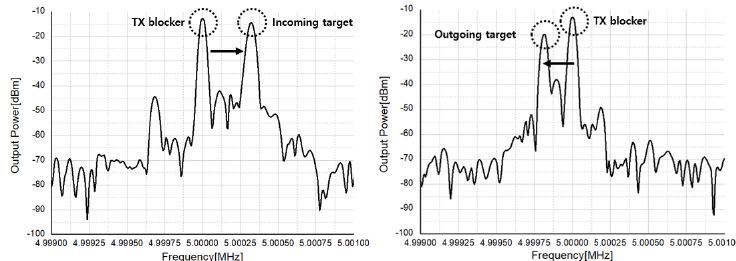
Figure 45. Measurement result of incoming (left) and outgoing targets (right).